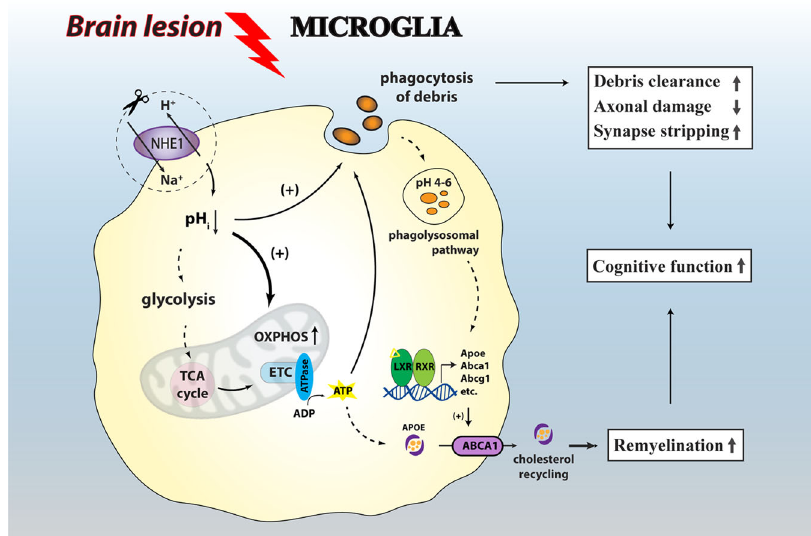
Fig. 8 Illustration of NHE-1-mediated microglial pH i regulation and immunometabolism in ischemic brain repair. Brain injury stimulates NHE1 protein expression in microglia, which mediates H + ef fl ux in exchange of Na + in fl ux and alkalinizes pH i in microglia. Selective deletion of microglial Nhe1 acidi fi es pH i , which is involved in boosting the immunometabolism of oxidative phosphorylation, as well as ATP production, which provides fuels for important microglial functions such as phagocytosis. Increased phagocytosis of debris improved debris clearance in favor of remyelination, reduced axonal damage, and promoted synaptic stripping for remodeling. The acidi fi ed pH i could also potentially bene fi t the phagolysosomal pathway to provide ligand for the activation of LXR/RXR pathway, which increase transcription of cholesterol transporter genes and promote cholesterol recycling to support remyelination. These changes may collectively contribute to cognitive function improvement after brain